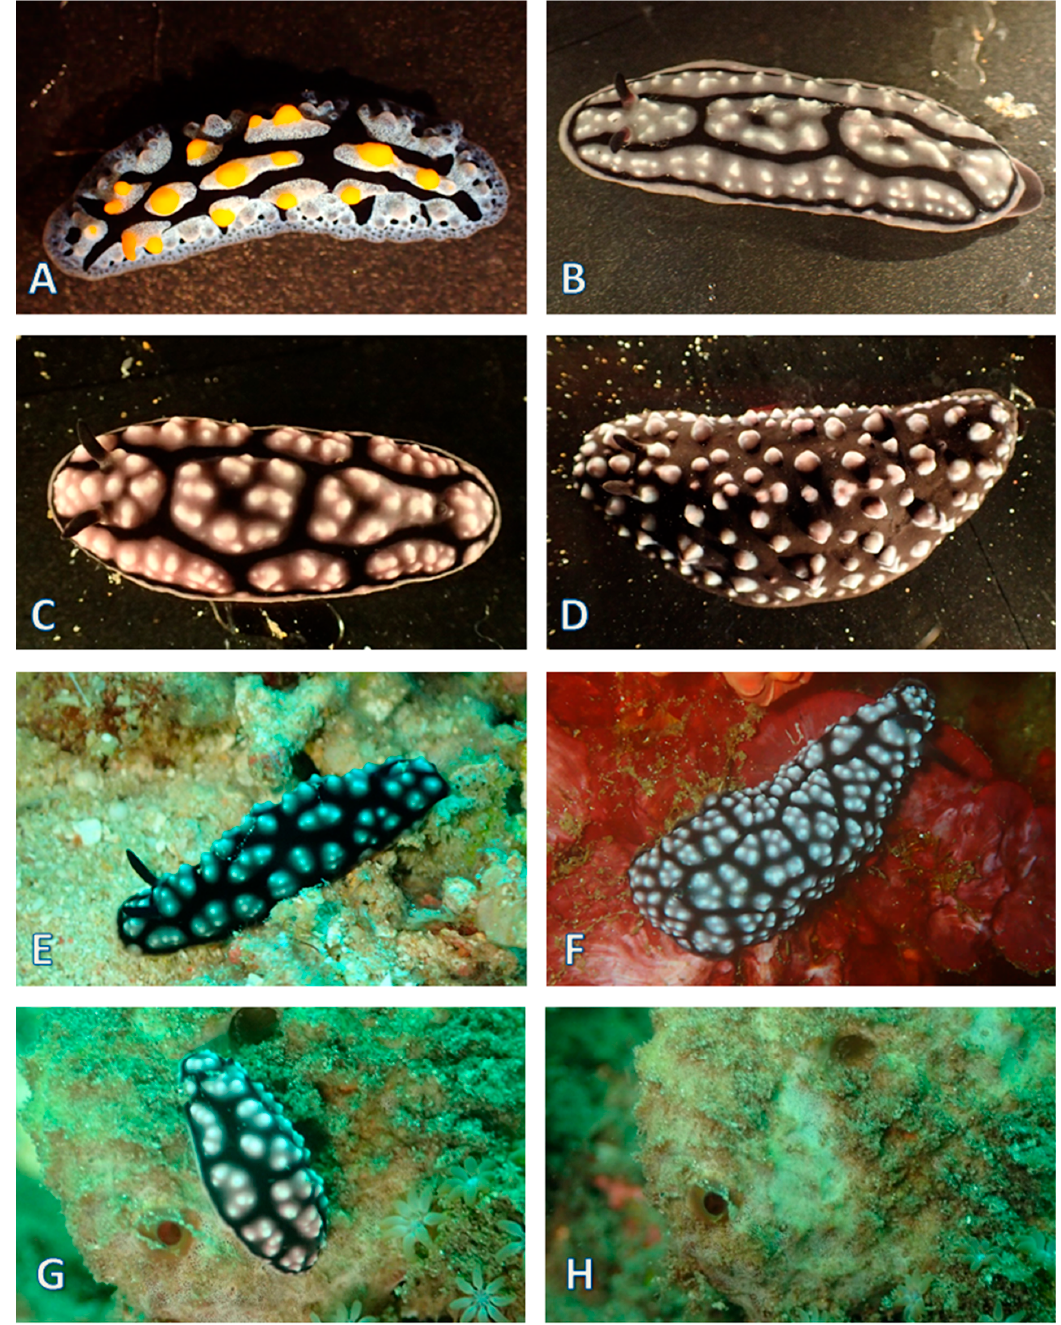
Figure 17. Nudibranchia Doridina: ( A ) Phyllidia sp. a, Phsp18Ba2; ( B ) Phyllidiella annulata , Phpu18Ba-12; ( C ) Phyllidiella lizae, Phli18Ba-1 ; ( D ) Phyllidiella nigra, Phni18Ba-1; ( E , F ) Phyllidiella pustulosa, Phpu18Ba-2, Phpu18Ba-4. ( G ) Specimen of Phyllidiella pustulosa in situ on a sponge; ( H ) Sponge viewed immediately after P. pustulosa was removed.